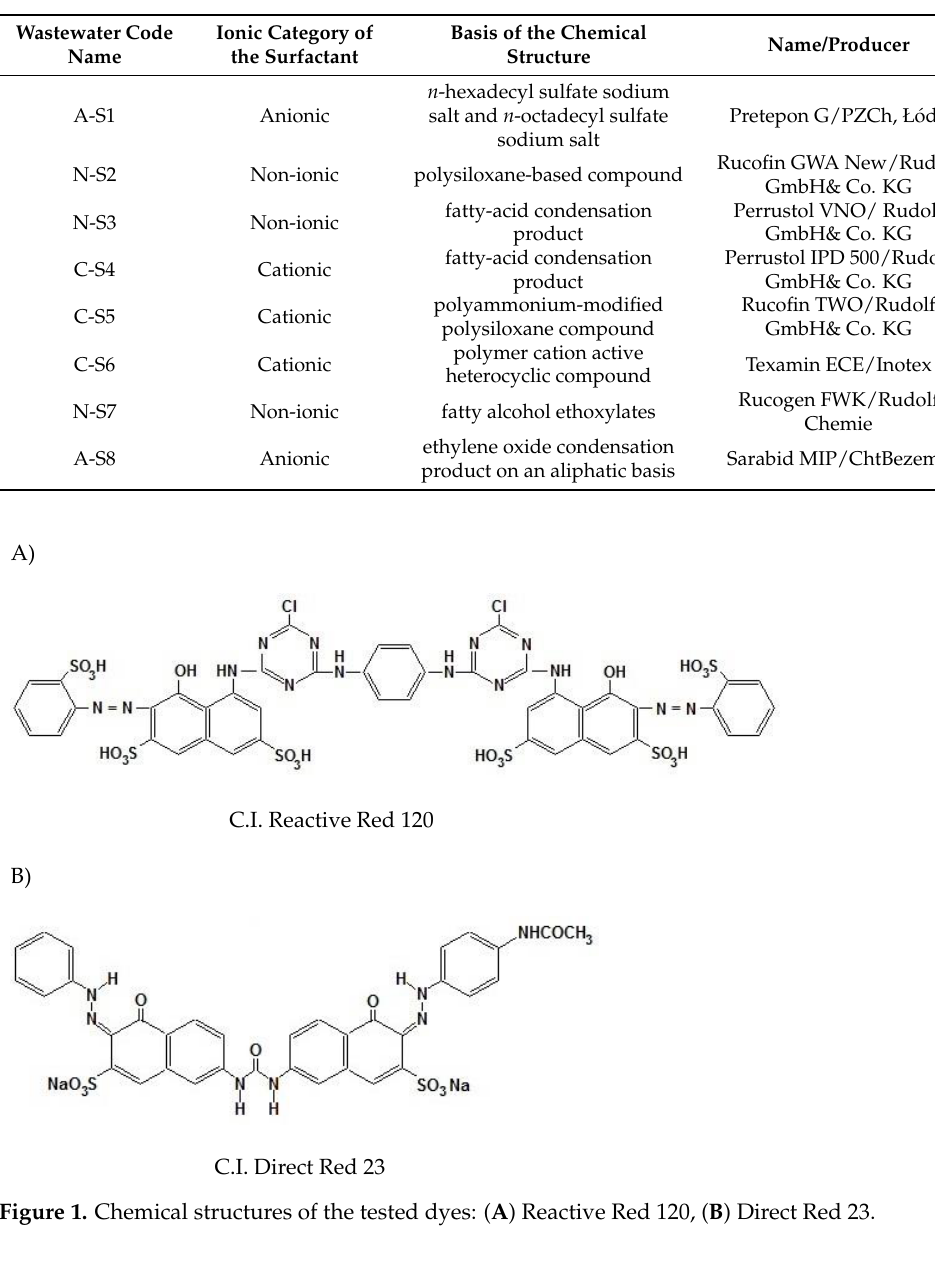
Table 1. Detergents used in the experiments.